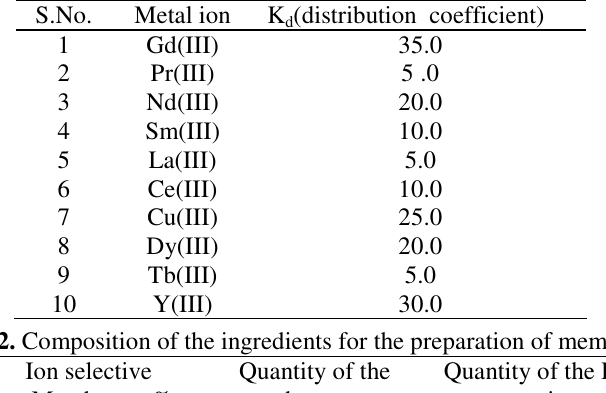
value for various metal ions. d